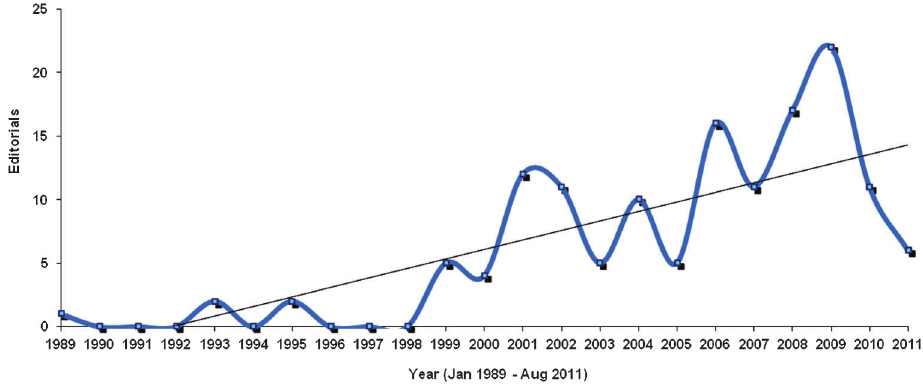
Figure 2. Editorials on conflicts of interest-related issues (Medline, Embase, Scopus, and Web of Science), January 1989-August